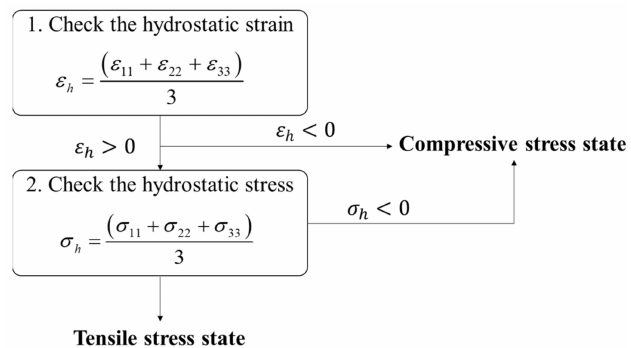
Figure 4. Schematic diagram of the procedure how to define the stress